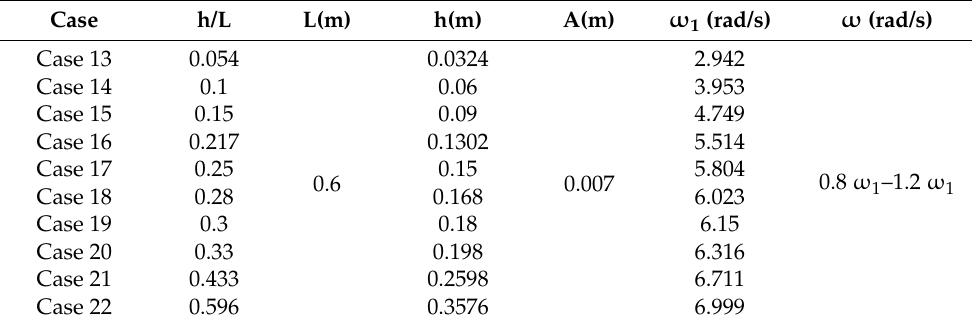
Table 3. The numerical case